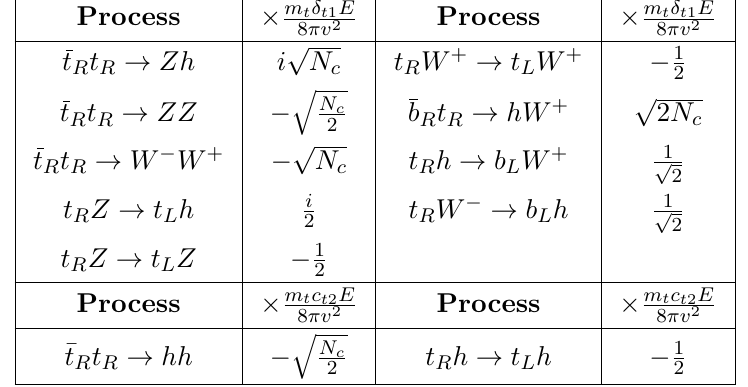
Table 6 . 4-body model-independent unitarity-violating processes from the top